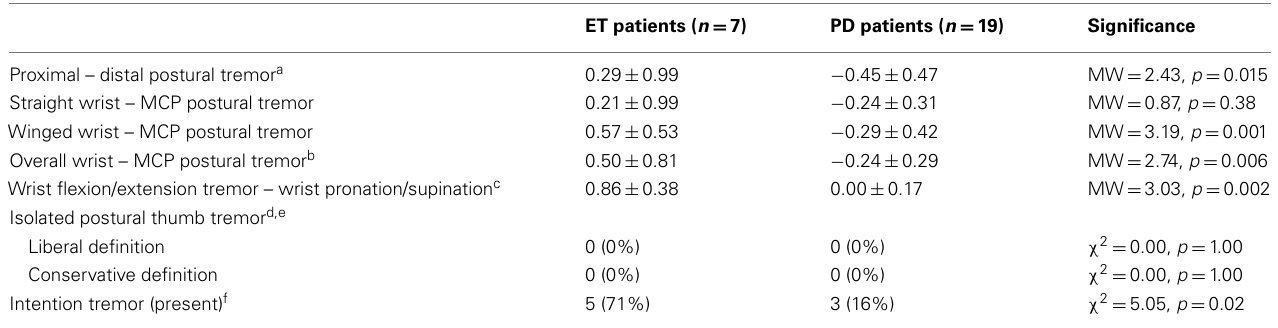
Table 4 | ET vs. PD – Main measures using only patients with ≤ 5years of